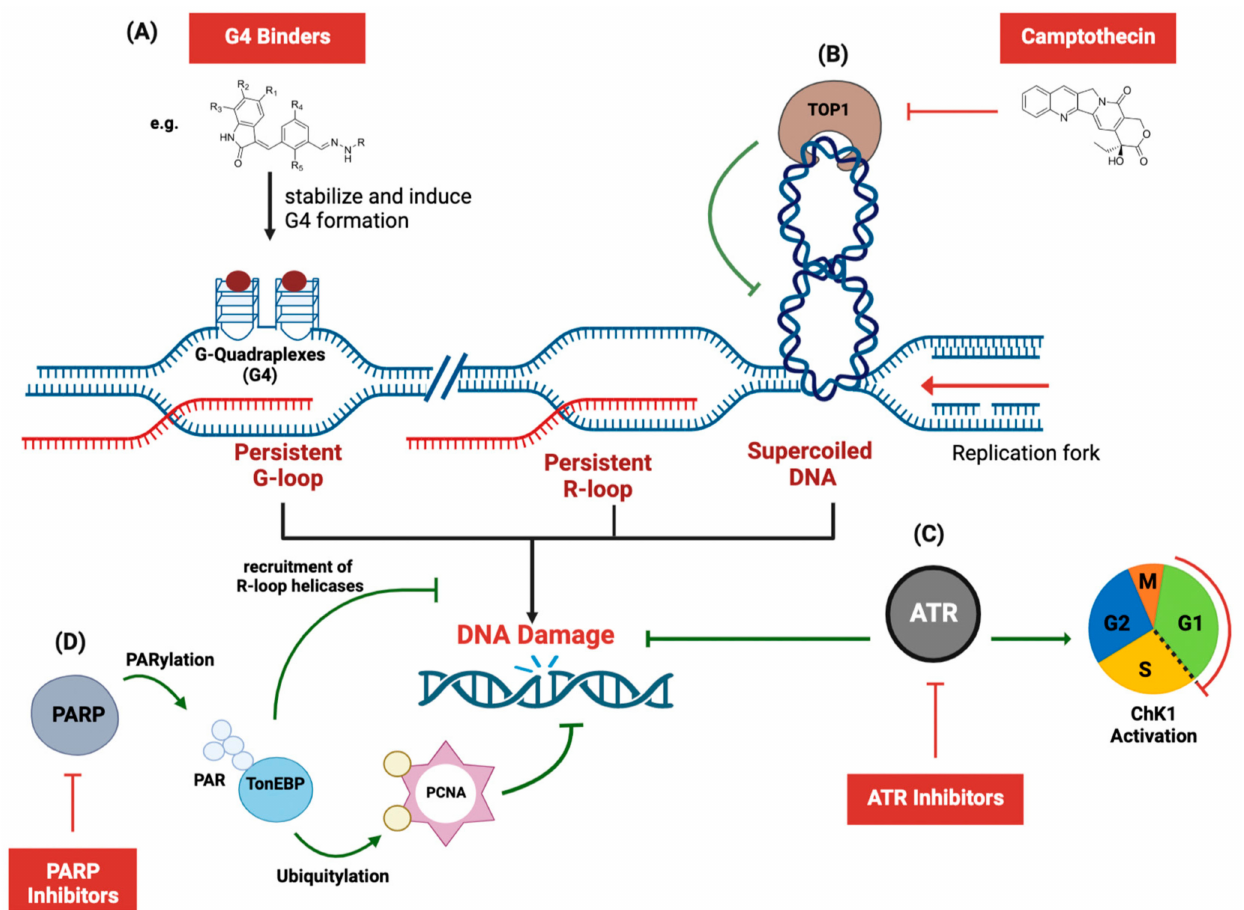
Figure 6. R-loop-induced genomic instability as a mechanism of action of DNA damaging agents explored in cancer therapy. ( A ) G4 binders such as Monohydrazone-derivatives stabilize G-loops (R-loops with G4 structures on displaced DNA) and thereby induce genomic instability [109,110]; ( B ) Supercoiling of the DNA can cause R-loop built-up and is rescued by the unwinding activity of topoisomerase I [29]. Inhibition of Topoisomerase, in turn, causes R-loop accrual and DNA damage; ( C ) R-loop induced double-strand break formation and subsequent DNA damage can also be sensed and repaired through the DNA damage response mediated by ATR-Chk1 activation, resulting in cell cycle arrest and fork recovery. Inhibition of ATR abrogates this repair mechanism, leading to toxic DNA damage [30,80,81]; ( D ) Moreover, PARP-mediated PARylation of the multifunctional DNA stress responder TonEBP signals PCNA ubiquitination, which recruits DNA repair proteins to the site of DNA damage. Inhibition of PARP blocks TonEBP-parylation and abrogates subsequent protection against R-loop accumulation [112]. PARP (DNA repair protein): poly(ADP-ribo)polymerase; TonEBP (transcription factor): Tonicity-responsive enhancer-binding protein; PCNA (DNA replication and repair factor): proliferating cell nuclear antigen; TOP1 (resolves DNA supercoiling): topoisomerase 1; ATR (DNA damage sensor): Ataxia telangiectasia-related; ChK1: checkpoint 1; G1: growth phase 1; S: synthesis phase; G2: growth phase 2; M: